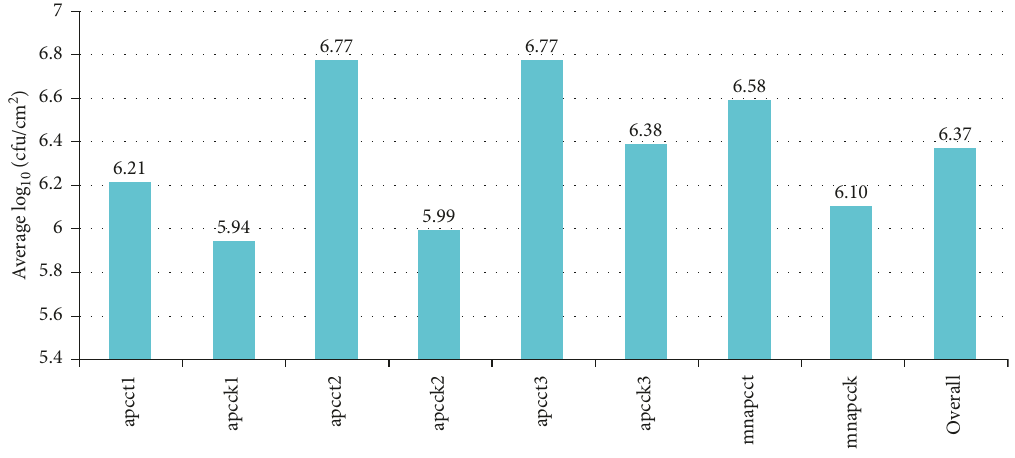
Figure 1: Aerobic plate count from cutting table and knife. ∗ apcct � aerobic plate count from cutting table; apcck � aerobic plate count from cutting knife; mn � mean.